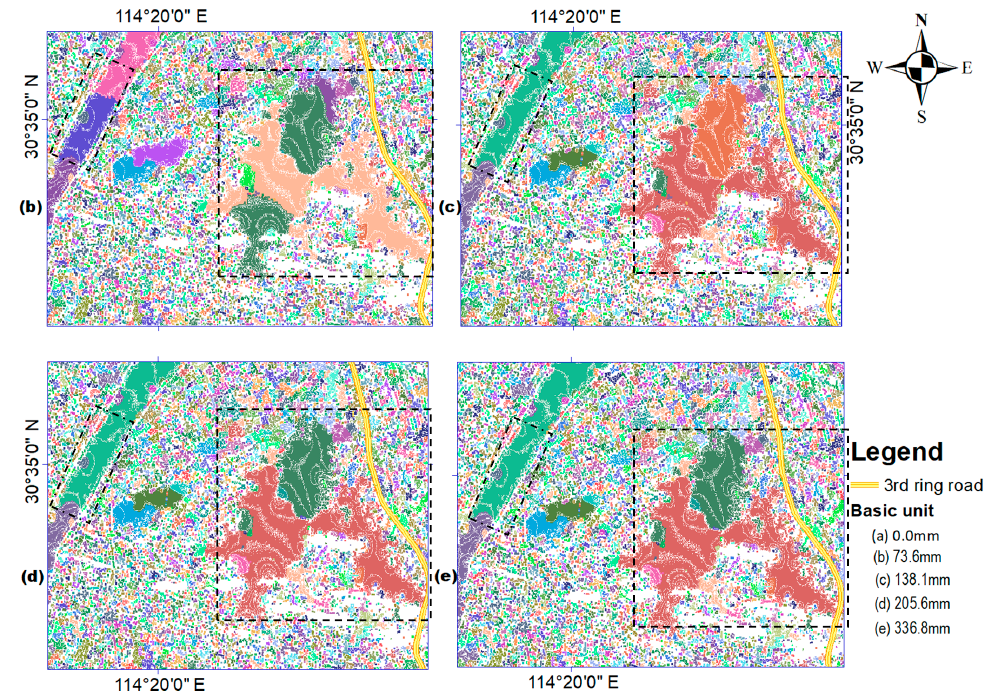
Figure 4. The sink areas identified by the dynamic catchment delimitation considering terrain connectivity. Figure ( a ) shows the basic sink areas, according to the original DEM. Figures ( b – e ) are the merged basic areas in terms of the neighborhood sink areas and precipitation. The cells with flow directions recorded as “0” are identified as sink areas, and the adjacent and continuous cells which can flow into the sink area are mapped as the same original basic units, as shown in Figure 4a. We find that the cells belonging to a large continuous area in a vector map (e.g., in the water layer, the cells in lakes, rivers, and reservoirs) cannot be definitely marked as in the same